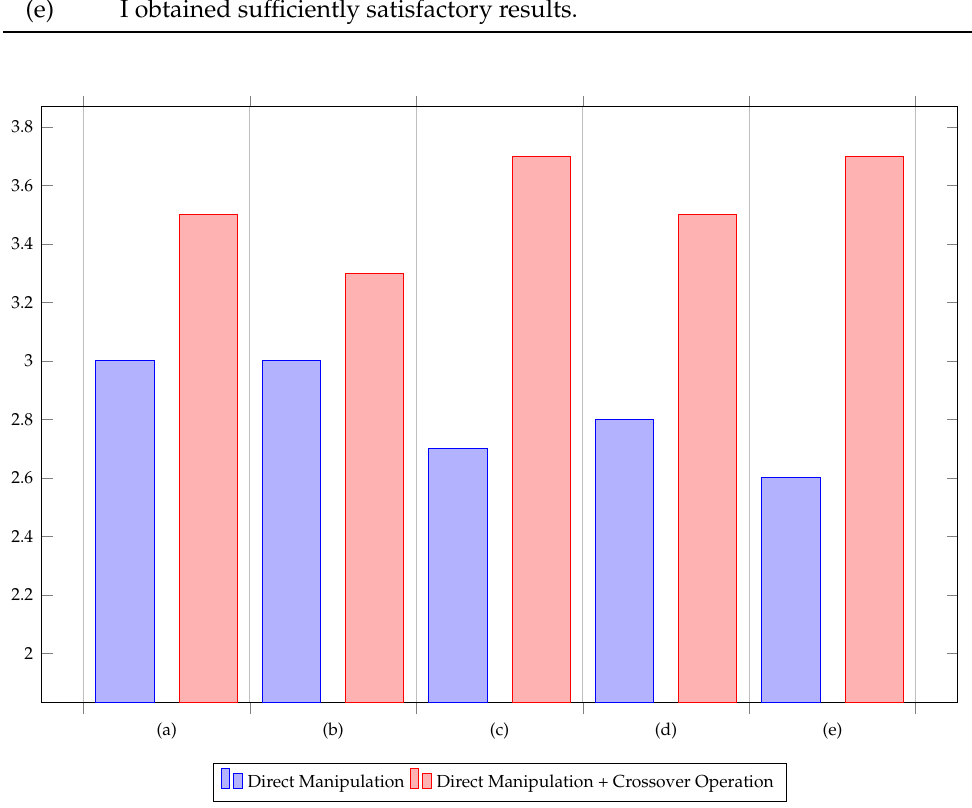
Figure 10. Survey results of five questions ( a – e ) about the given